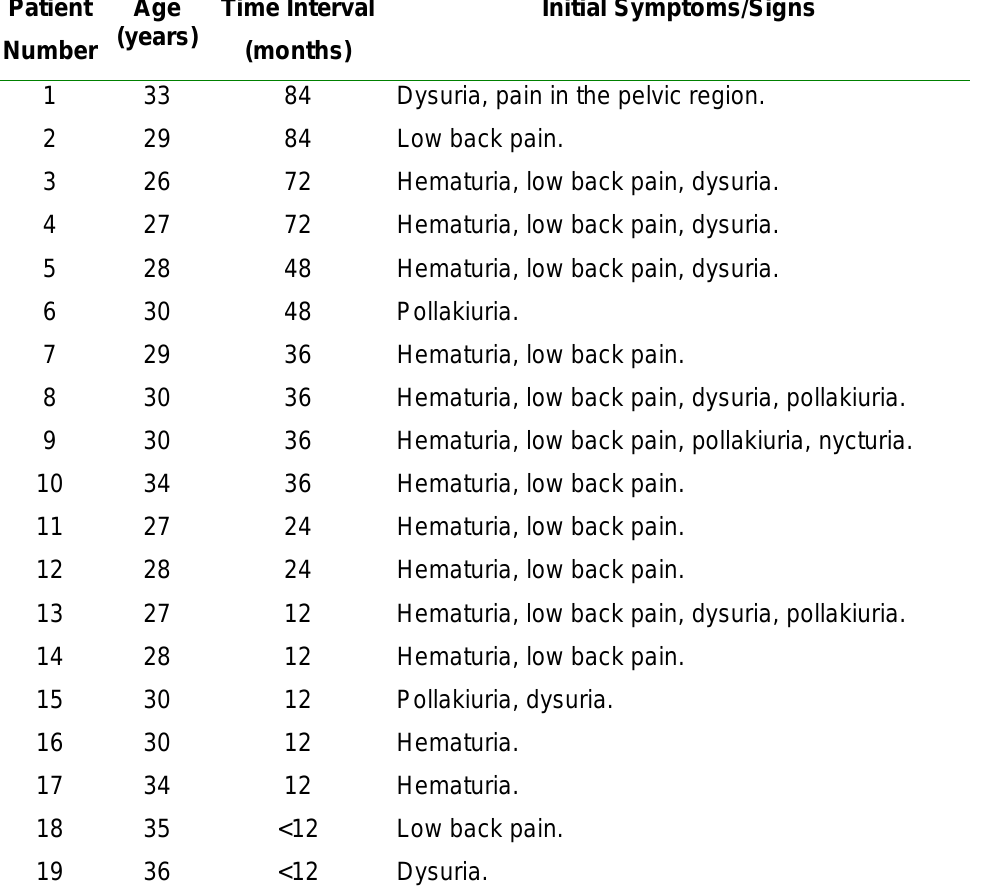
Table 1. Patients’ number, age and time interval between exposition to the parasite and initial manifestation (symptoms or